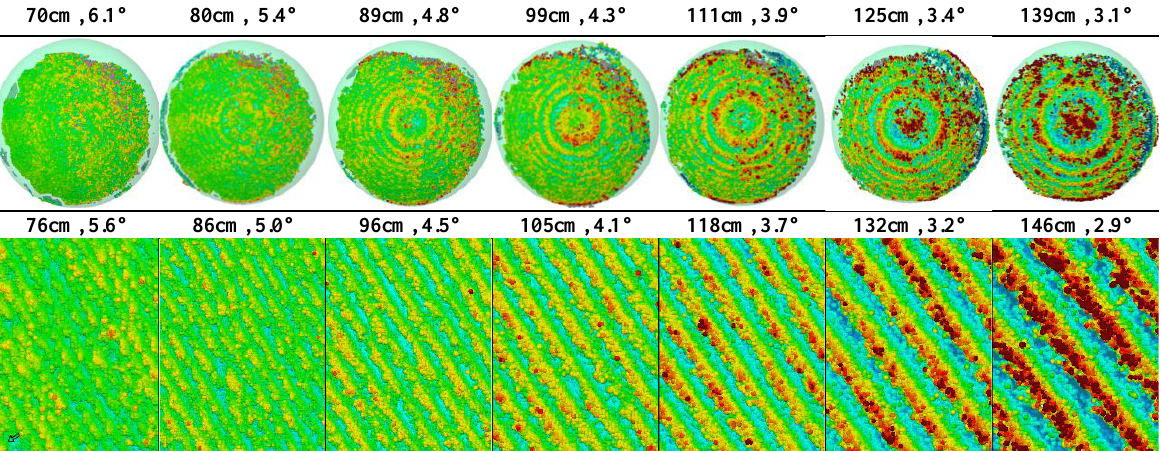
Figure 6: Evaluation of noise at the surface for very small intersection angles. A best fitting sphere and a best fitting plane were compared to the point cloud. With the decrease of intersection angles, the noise is increasing. The visible pattern represents the discretization error, since the disparity range is very small and the subpixel measurement precision in image space is limited.